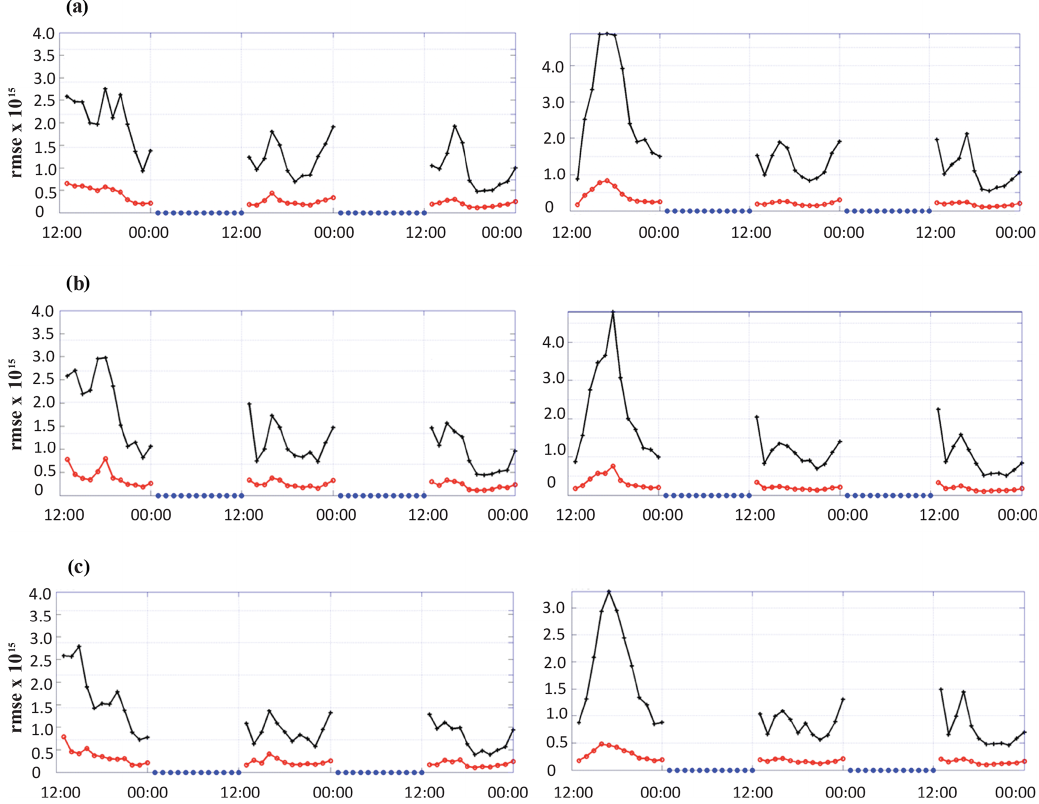
Figure 3. (a) Evaluation of the time evolution of TEMPO column NO 2 observations in Denver from 2 July at 16:00 to 5 July at 00:00UTC for the CHEM experiment. Prior (black) and posterior (red). Left: RMSE, right: spread. (b) Evaluation of the pseudo TEMPO column NO 2 observations in Denver from 2 July at 16:00 to 5 July at 00:00UTC for the ( T , RH, CHEM) experiment. Prior (black) and posterior (red). Left: RMSE, right: spread. (c) Evaluation of the time evolution of the pseudo TEMPO column NO 2 observations in Denver from 2 July at 16:00 to 5 July at 00:00UTC for the (MET, CHEM) experiment. Prior (black) and posterior (red). Left: RMSE, right: spread. Table 1. RMSE of assimilated U (left) and V (right) daytime winds. Assimilated U Assimilated V Without assimilated With assimilated Without assimilated With assimilated chemistry chemistry chemistry chemistry